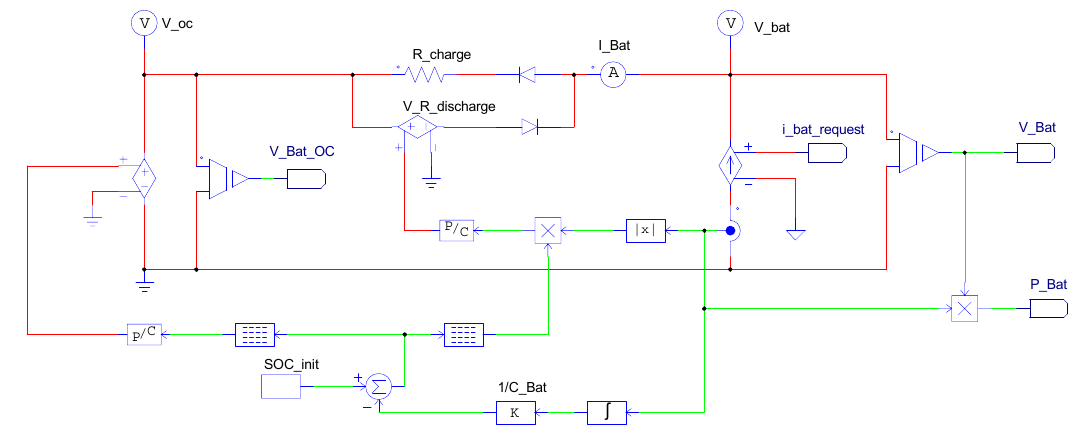
Figure 13. Implementation of the Rint model.